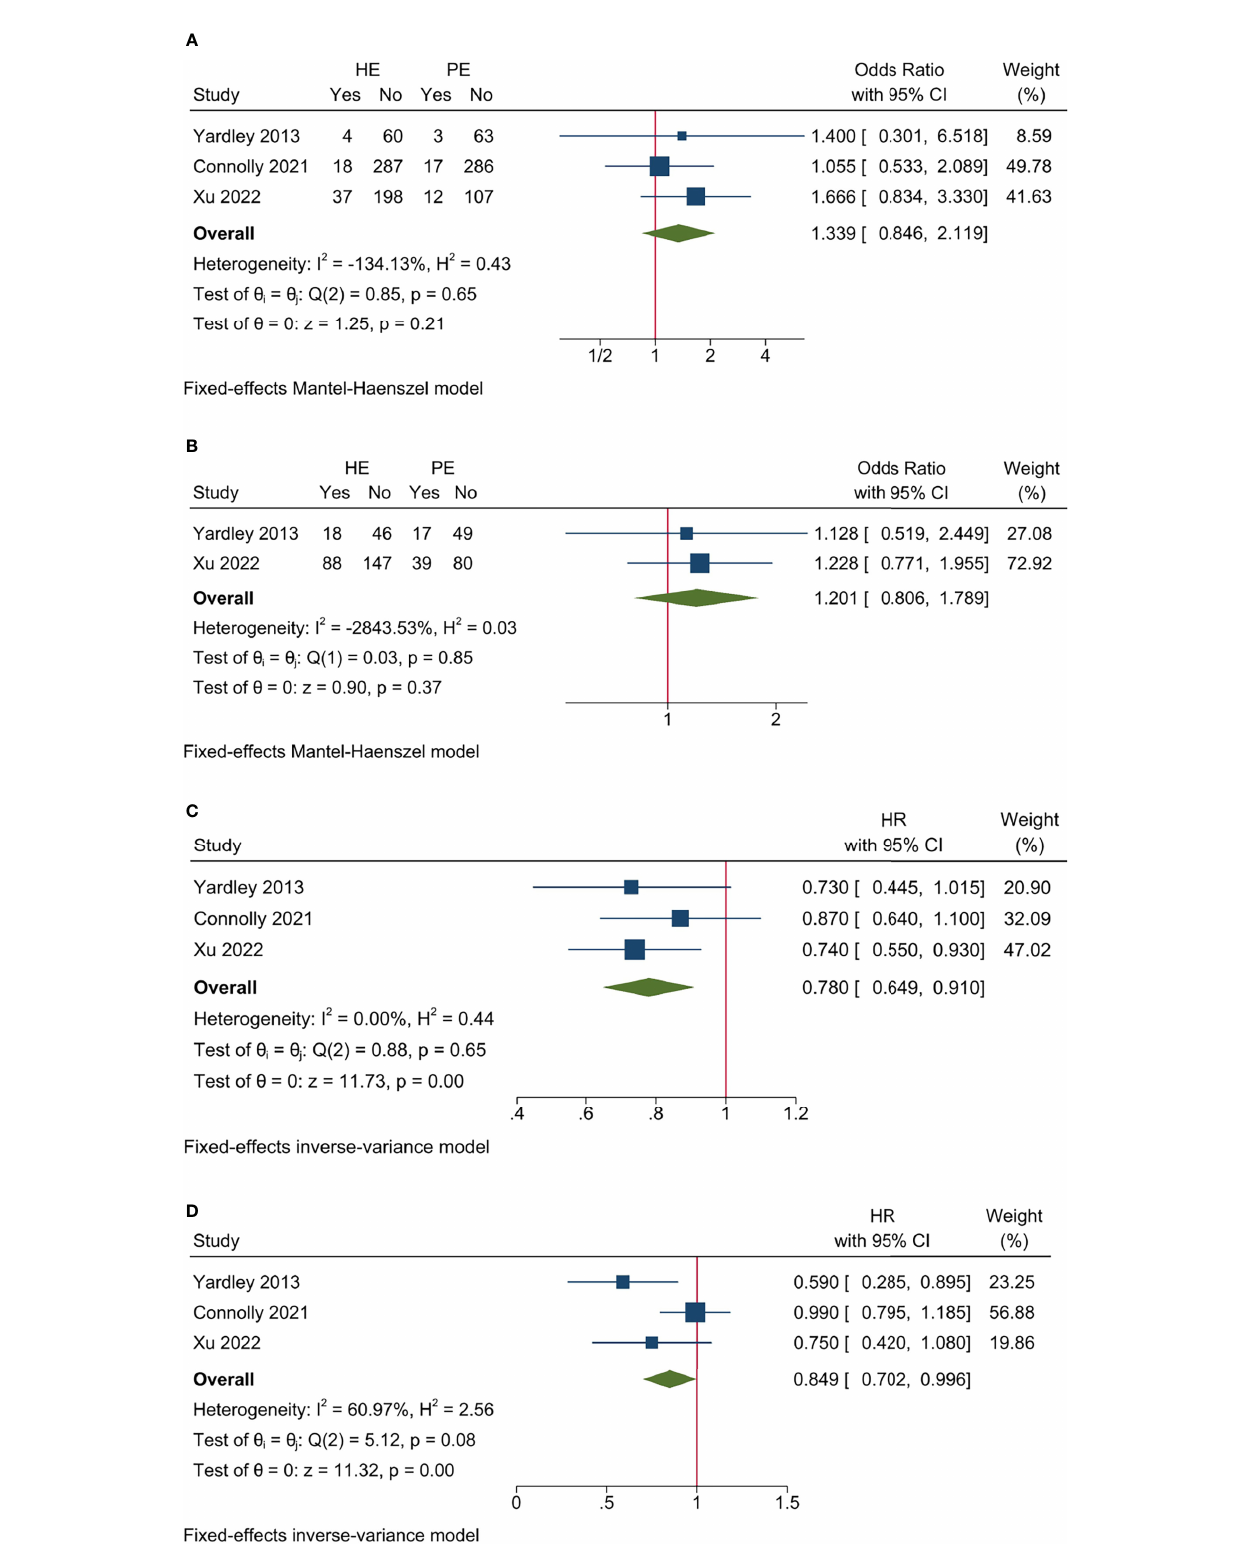
FIGURE 5 | Sensitivity analysis for ef fi cacy endpoints of studies on entinostat. (A) ORR; (B) CBR; (C) PFS; (D)